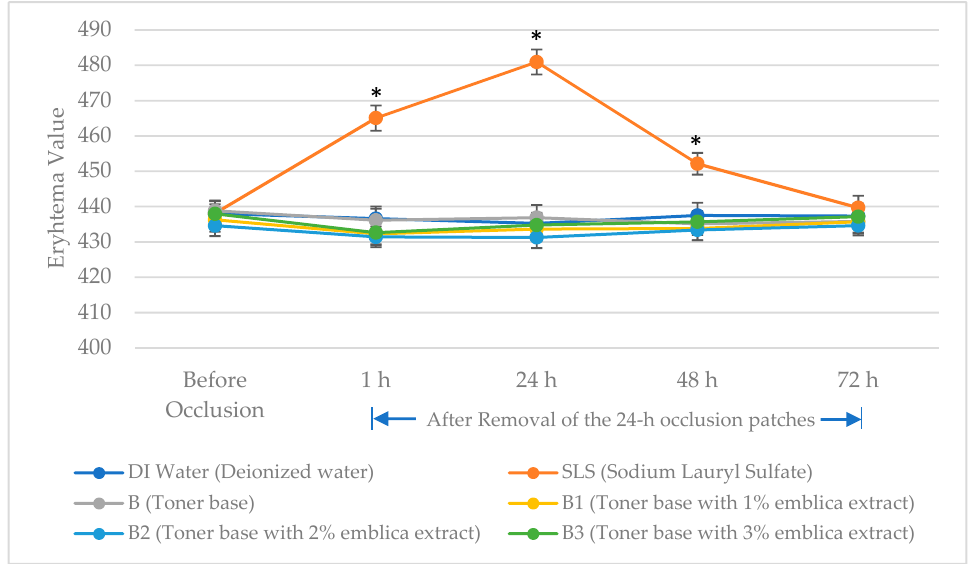
Figure 3. Erythema index of skin irritation test at different periods of 30 volunteers. * indicates Figure 3. Erythemaindexofskinirritationtestatdifferentperiodsof30volunteers.* indicates statistically statistically significant differences between erythema index after removal of the 24-h occlusion significant di ff erences between erythema index after removal of the 24-h occlusion patches and before patches and before occlusion ( p < 0.05). occlusion ( p <